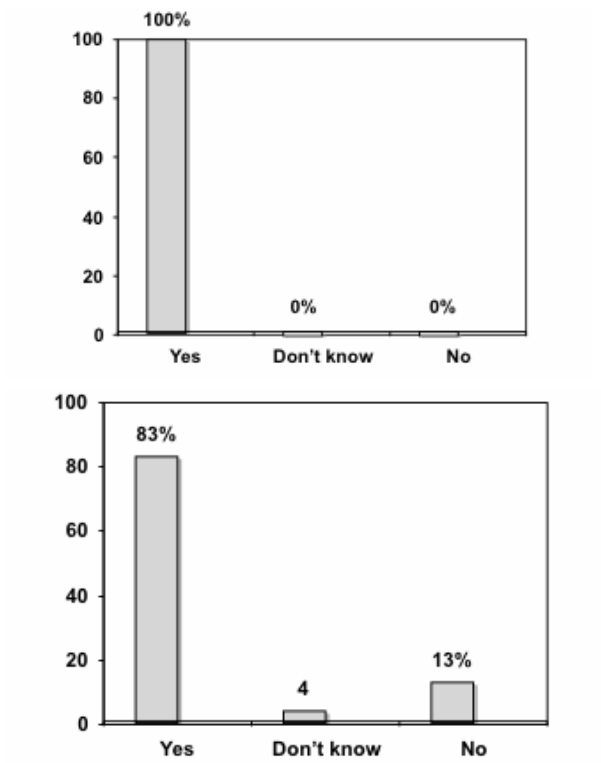
Figure 2: Did Mindmanager X5 Pro Add Any Value As A Facilitation Tool? Figure 3 refers to responses of project managers and team members regarding the value added by the tool in relation to communication.